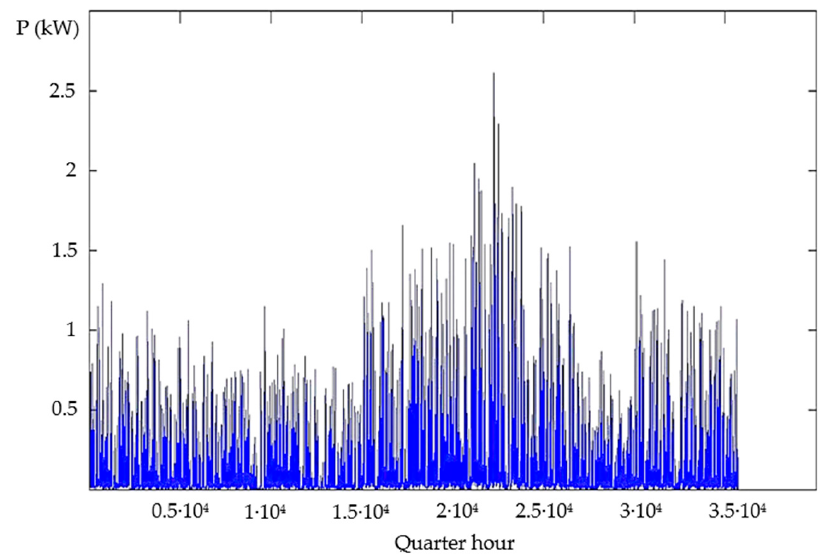
Figure 4. Yearly load profile generated for an LV user with 3 kW contractual power.